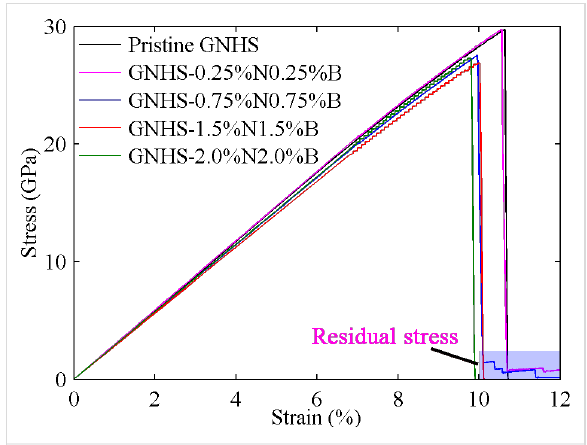
Figure 7: Stress–strain curves of GNHS with different densities of B- and